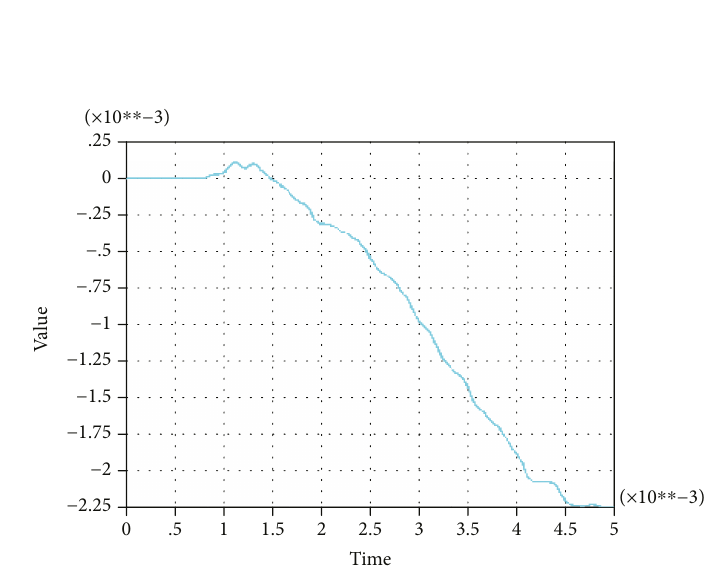
Figure 19: UY displacement response of the No. 1 node.